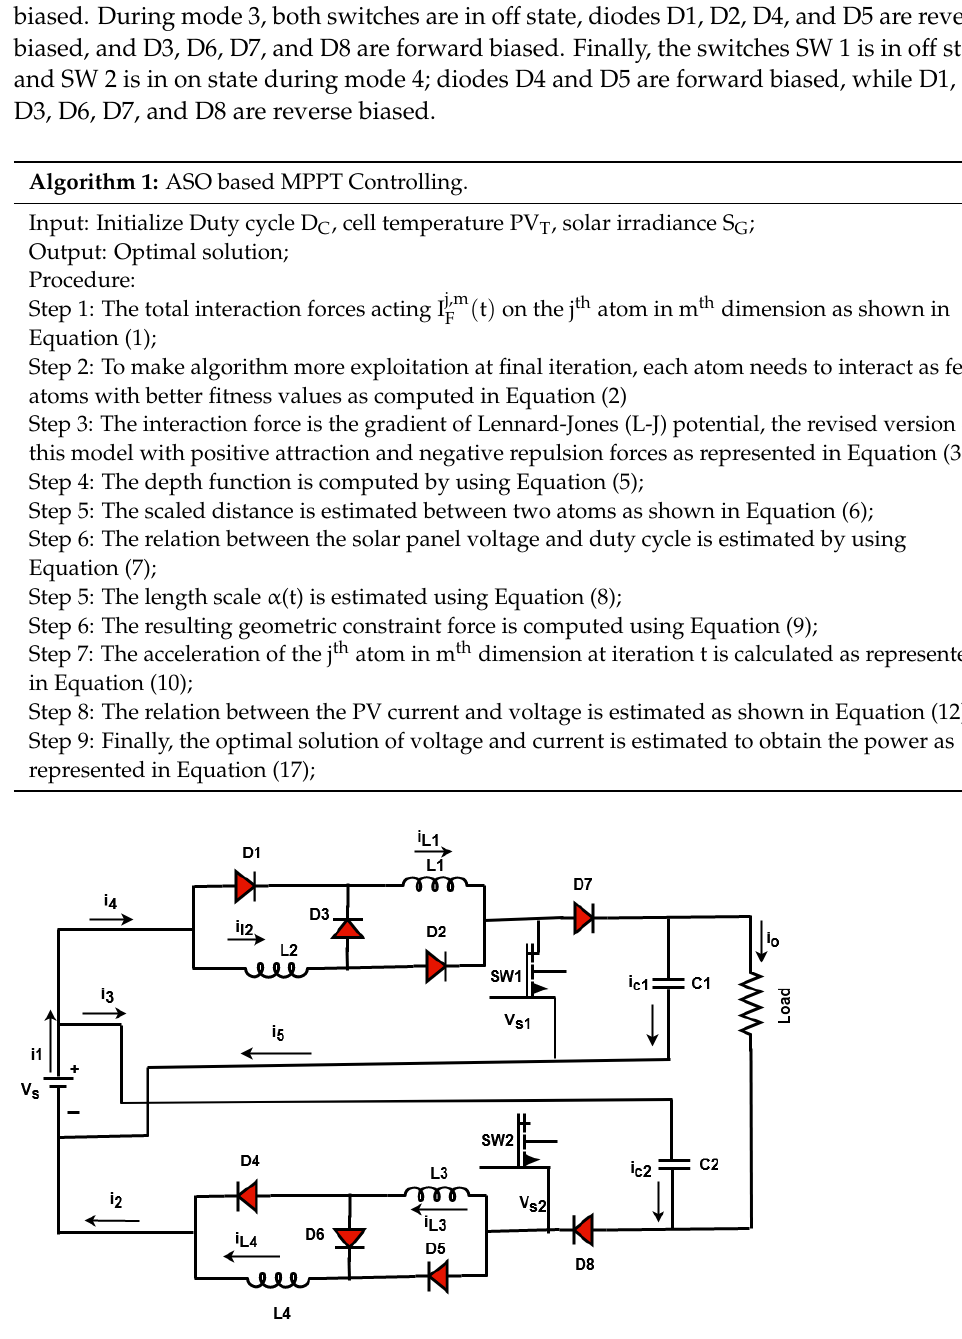
Figure 4. Equivalent circuit model o f isolated high voltage gain DC−DC converter.